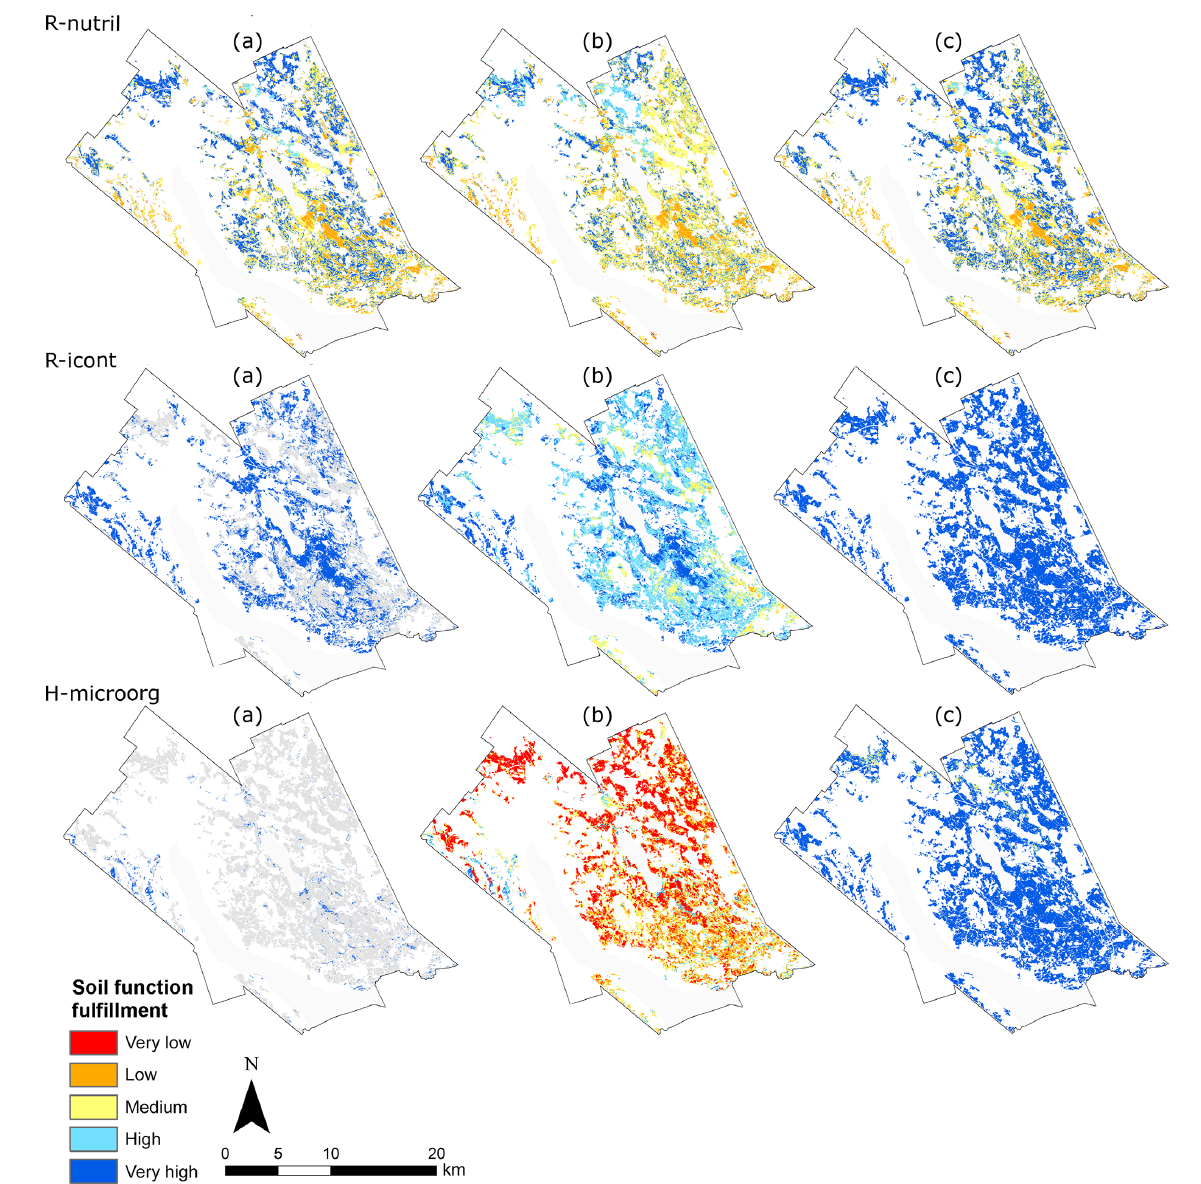
Figure 4. Uncertainty indication for soil function maps of R-nutril, R-icont, and H-microorg: (a) only mean SFF scores for raster cells are displayed if at least 90% of the N = 1000 simulations per raster cell revealed the same SFF score (first column). In addition, the range of SFF scores for each raster cell is shown: (b) 5 and (c) 95% percentiles of SFF scores, respectively (SFF, soil function fulfillment, in grey; not C90 or no assessment in light grey; lakes, “Arealstatisik” 2009, 72 classes, ©BFS 2010,